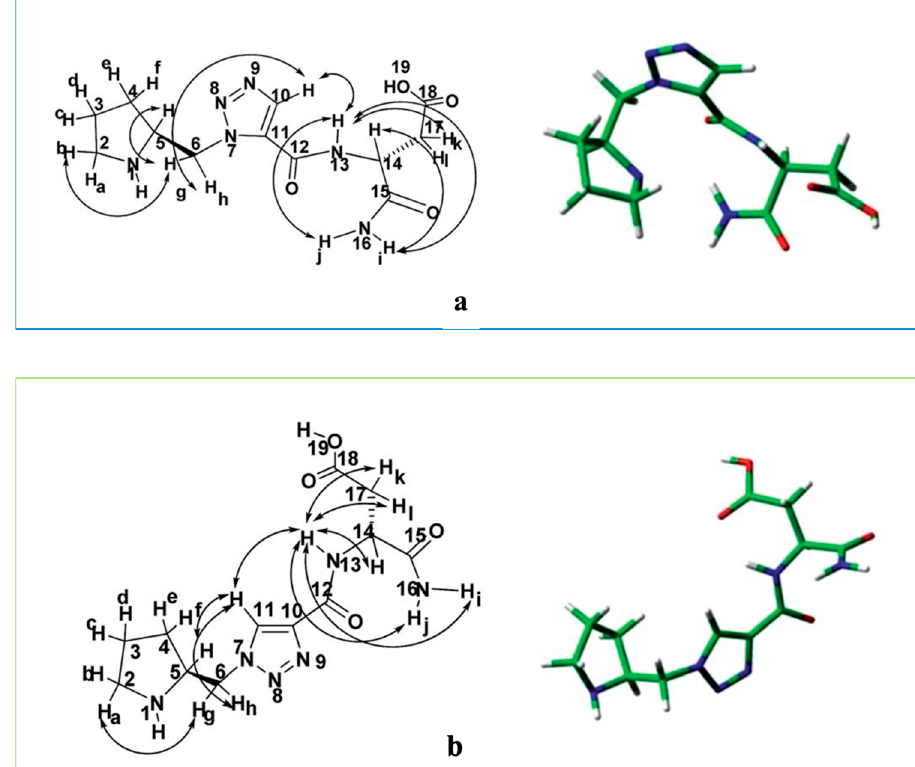
Figure 8. ROE-restrained molecular dynamics studies for catalyst 68 ( a ) and 68a ( b ). Adapted with permission from [51]. Table 6. Asymmetric Michael addition performed by peptidomimetic triazole-based catalysts.